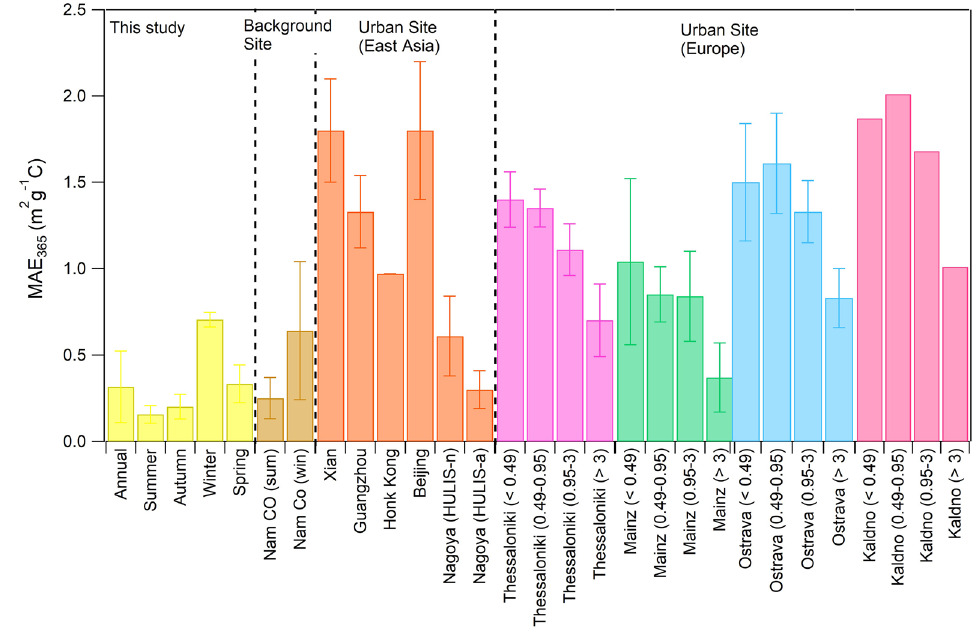
Figure 5. Comparison of MAE 365 of HULIS from this study with the values at a background site 30 , urban sites of East Asia 18,23,43,44 and urban sites of Europe 45 . The bar indicates the standard